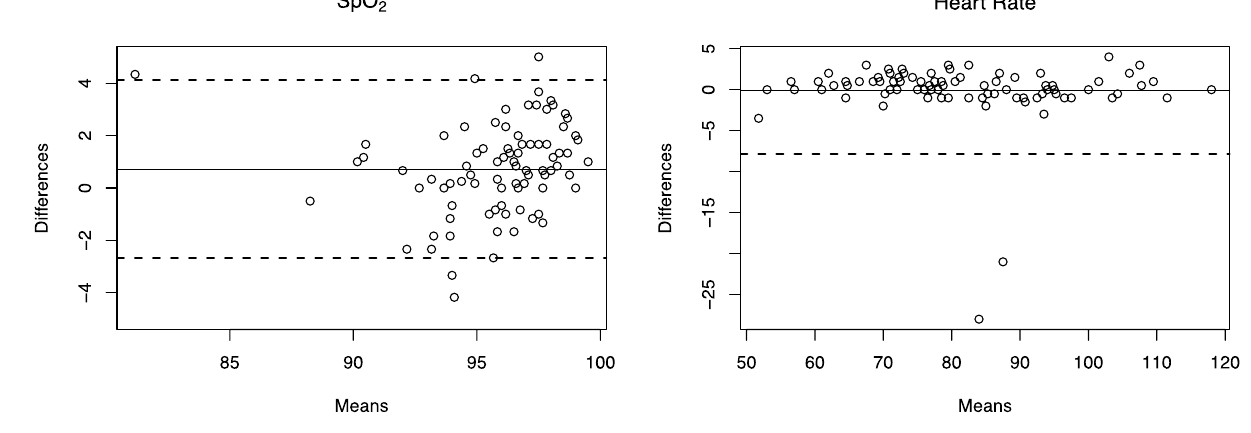
Figure 2. Bland–Altman plots of SpO 2 and heart rate of COPD and ILD patients and healthy volunteers. Solid lines show the mean bias. Dashed bias represents upper and lower limits of agreement.